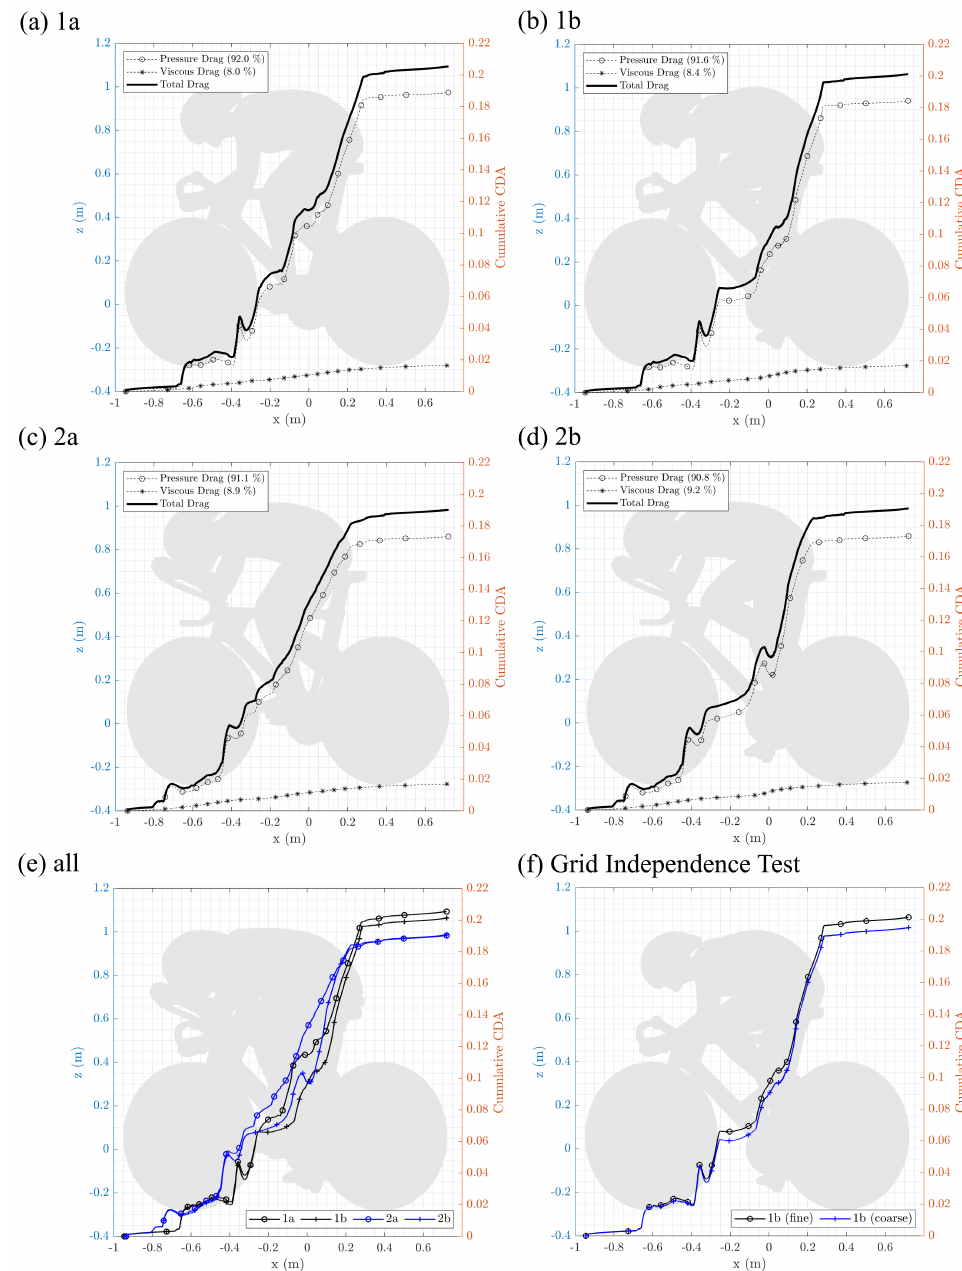
Figure 5. Cumulative (pressure and skin friction) drag profiles across the rider/bicycle with stream- wise distance: ( a ) 1a, ( b ) 1b, ( c ) 2a, ( d ) 2b, ( e ) all 4 cases, ( f ) 1b with fine and coarse